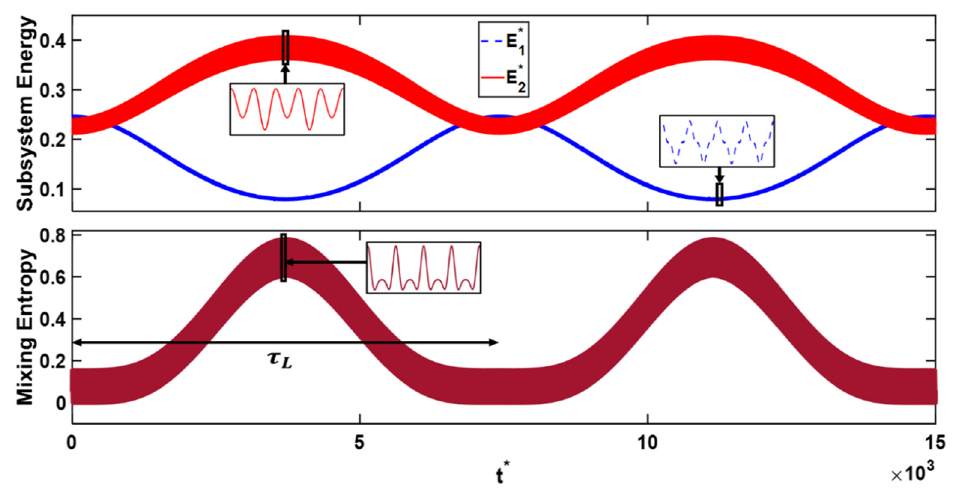
Figure 2. Normalized electrical ( 𝐸 (cid:2870)∗ ) and mechanical ( 𝐸 (cid:2869)∗ ) energies ( top ), and instantaneous mixing entropy ( bottom ) as a function of the nondimensional time t* . Insets show the local high frequency vibrations.